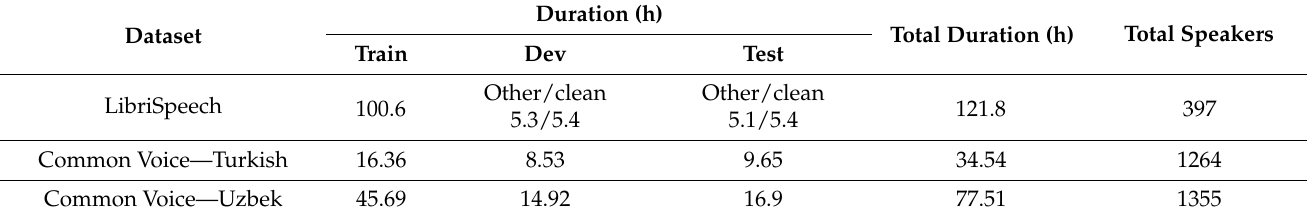
Table 1. Specifications of the LibriSpeech, Turkish and Uzbek corpus datasets.